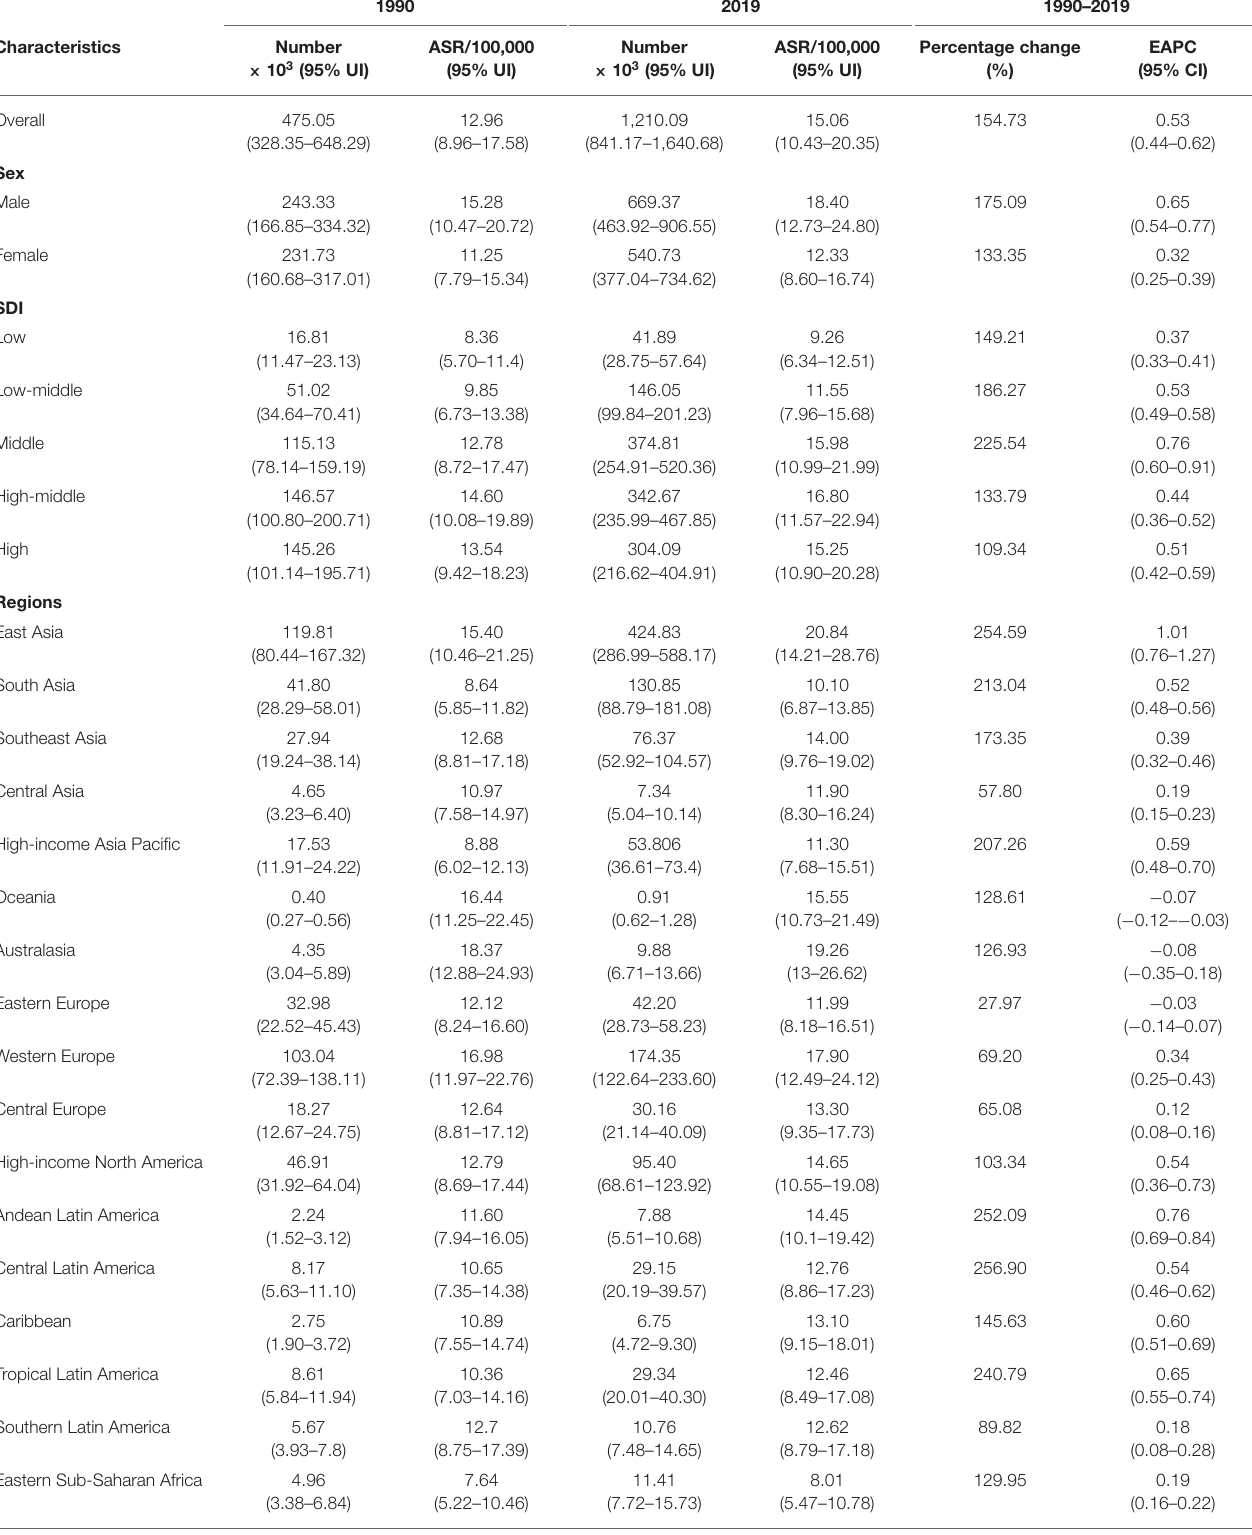
TABLE 2 | The changes in YLDs of Parkinson’s disease worldwide, and in sexes, SDI areas, and regions,